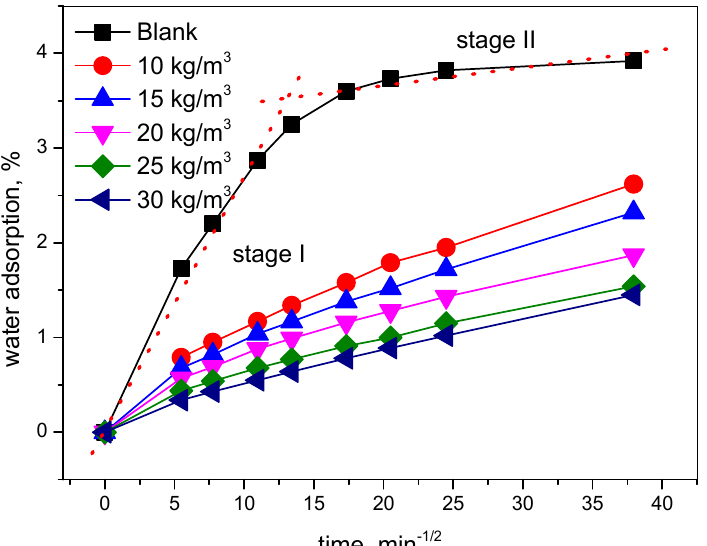
Figure 2. Water adsorption of concrete with different concentrations of a hydrophobic admixture as a function of test time .